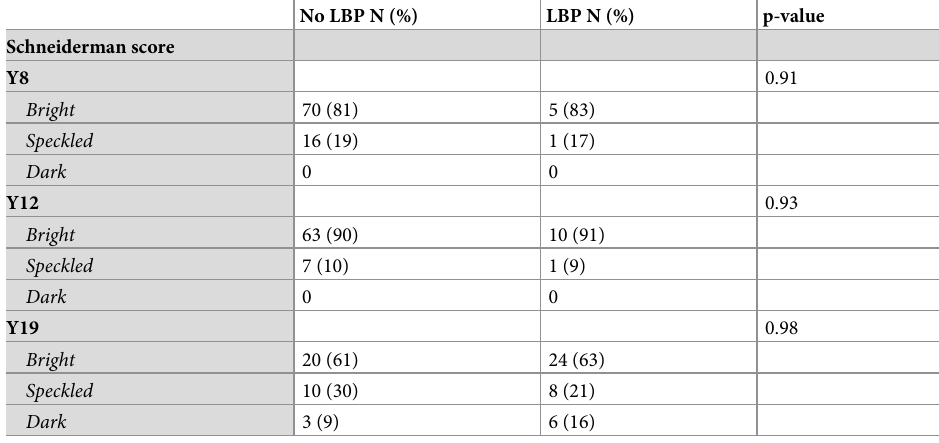
Table 2. Association of the visual assessment of the most degenerated disc to self-reported